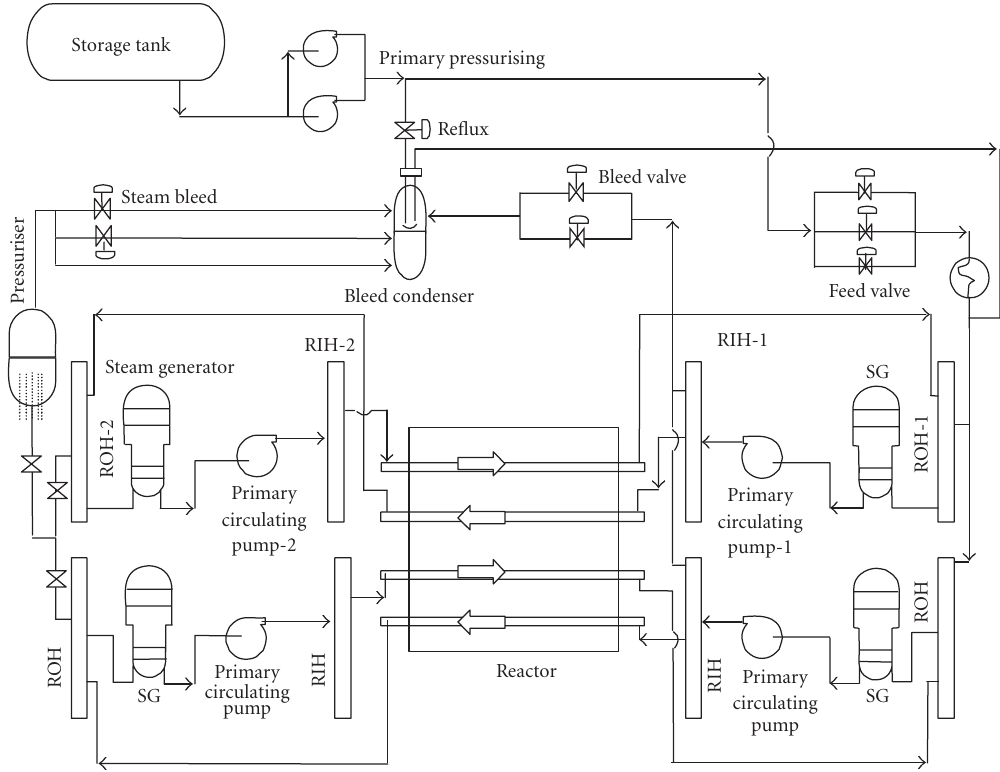
Figure 1: 700 MWe PHWR primary heat transport